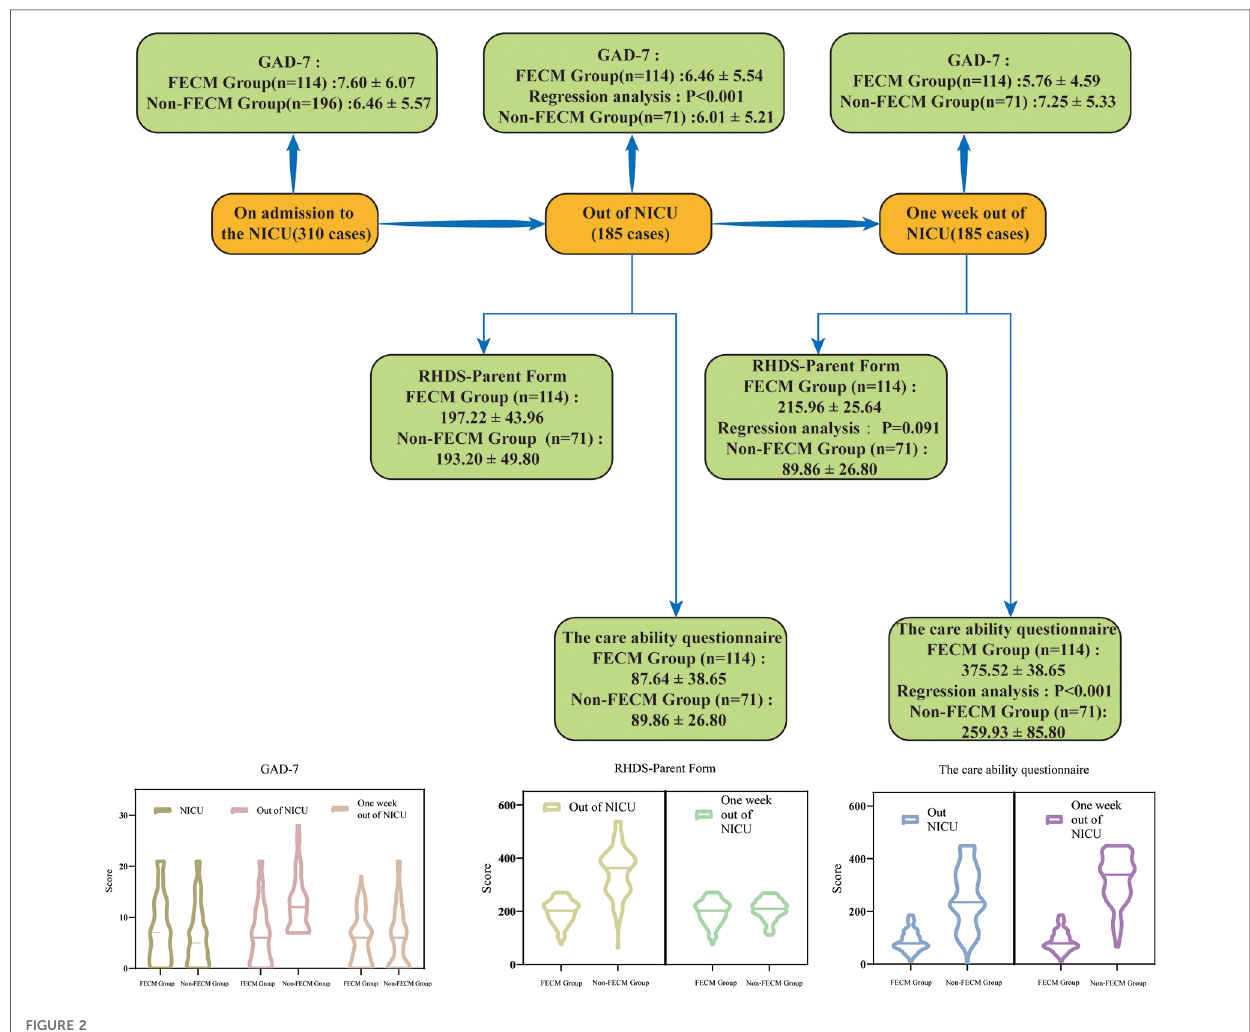
FIGURE 2 A summary fi gure of the